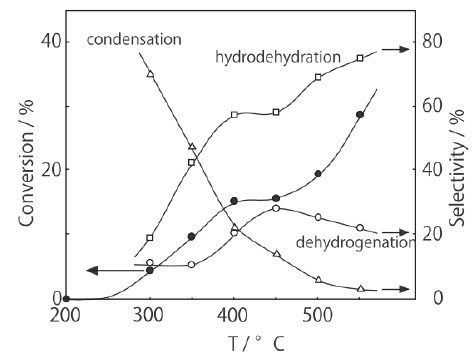
Figure 5. Reaction scheme of ( a ) cyclohexanone; ( b ) 2-cyclohexen-1-one, and ( c ) cyclohexene over (H